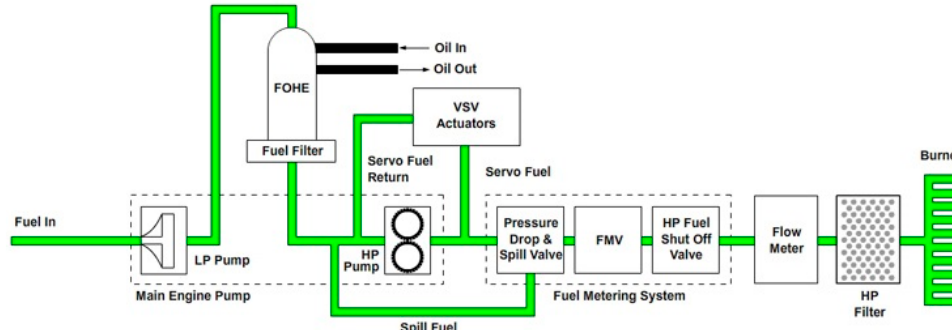
Figure 2. Schematic of B777’s airframe fuel system [17].